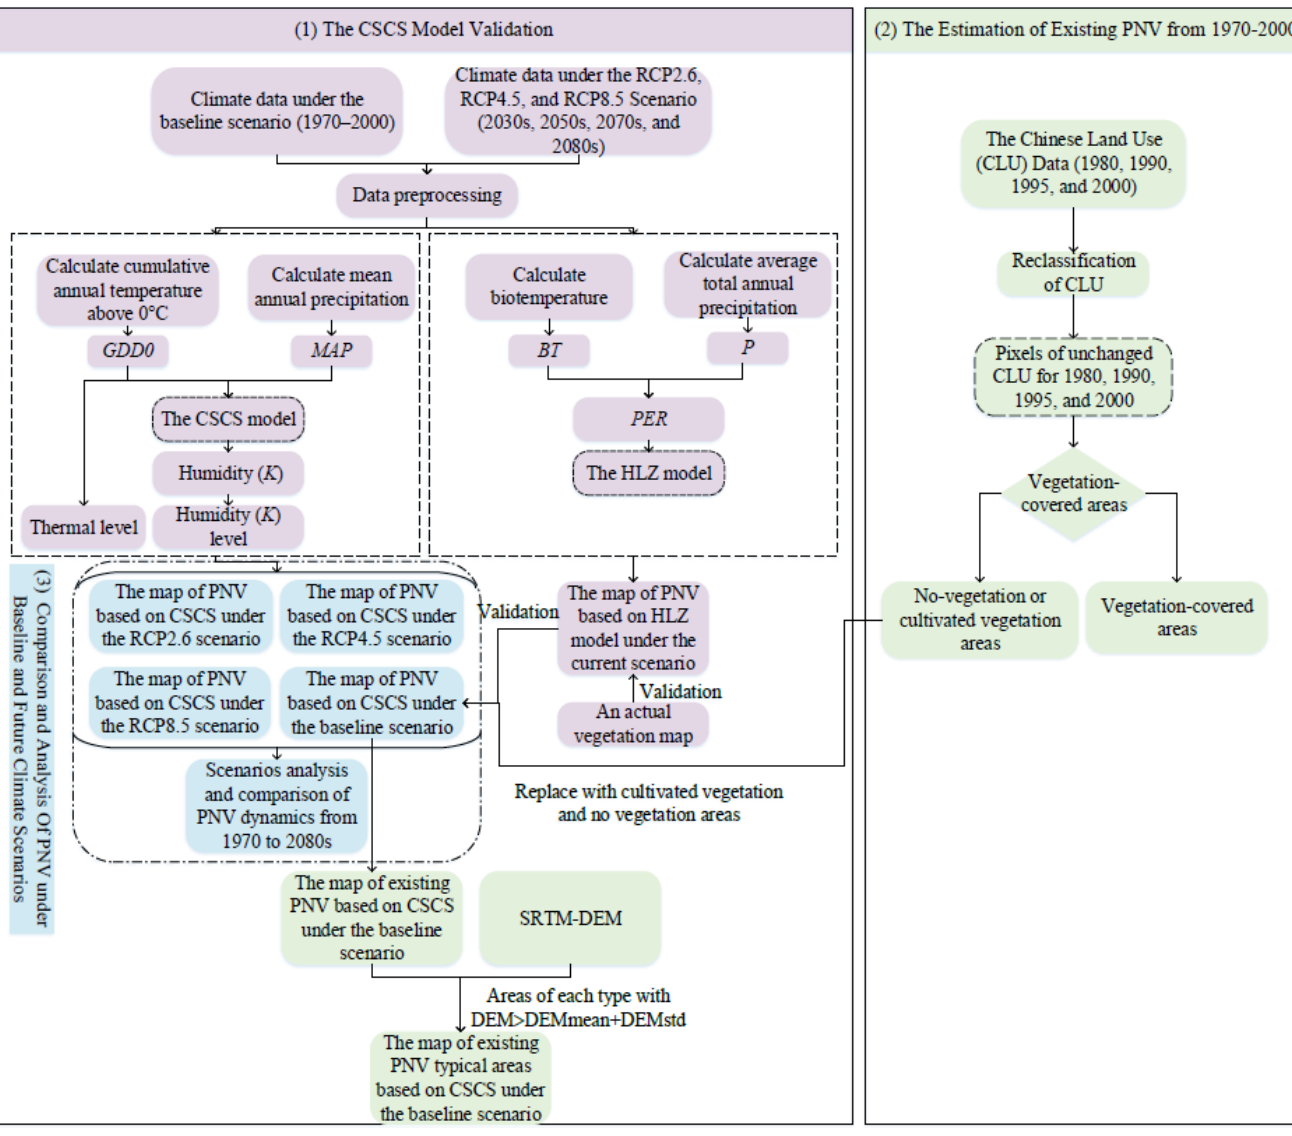
Figure 2. Flowchart of methods used in this study. CSCS model is the Comprehensive Sequential Classification; HLZ model is the Holdridge Life Zone model; PNV is Potential Natural Vegetation.